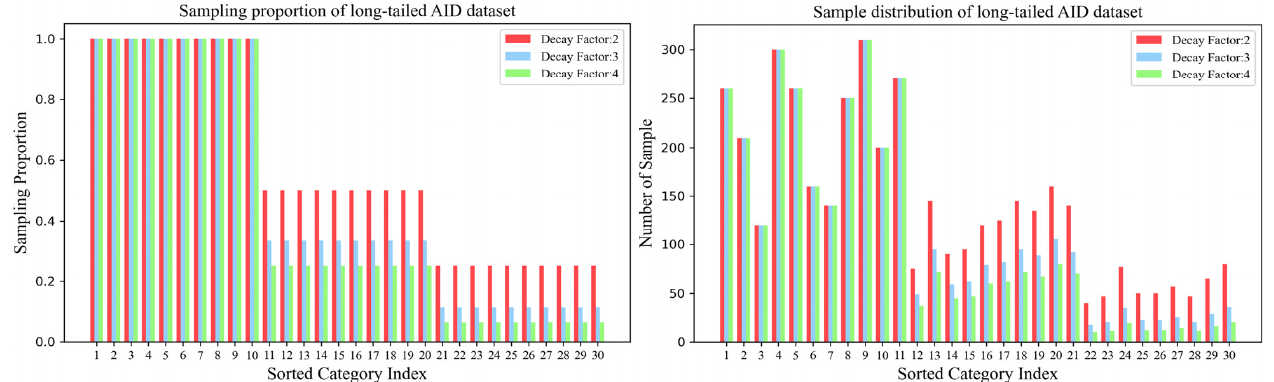
Figure 5. Long-tailed sampling percentage of the AID dataset and the distribution of the number of samples from each category after long-tailed processing.